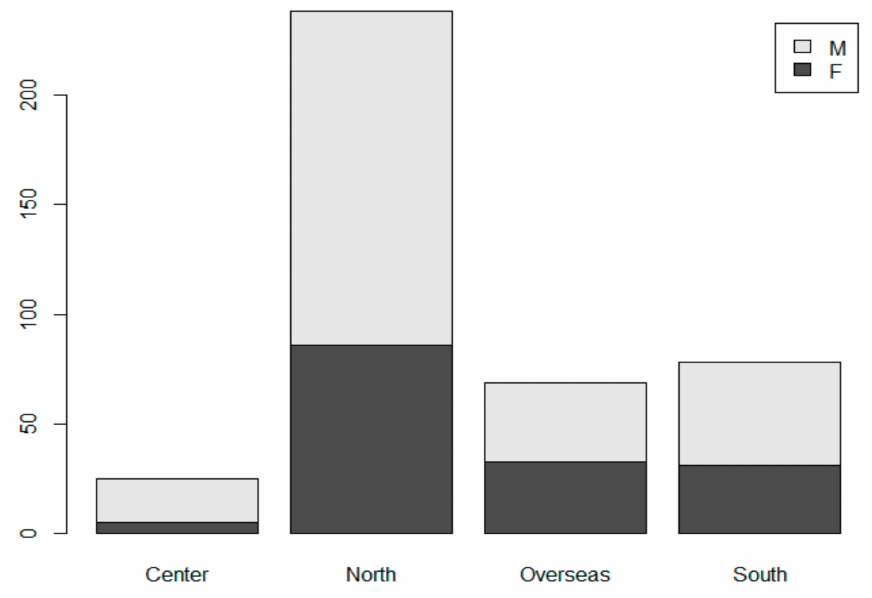
Figure A1. Regional and gender distribution of